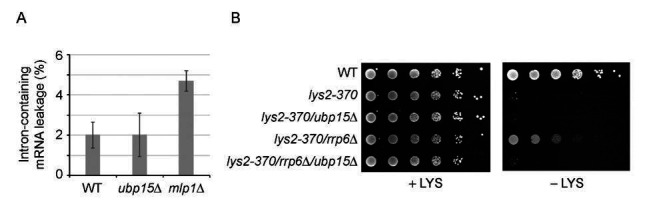
Deletion of UBP15 does not lead to increased levels of aberrant mRNAs in the cytoplasm.A) % of intron-containing mRNAs leaking into the cytoplasm, as measured using the “Leakage assay” described before (Legrain and Rosbash, 1989, Rain and Legrain, 1997) in WT, ubp15Δ and mlp1Δ cells. mpl1Δ is used as a positive control. B) The indicated mutants were grown overnight in YPD, serial-dilated (10-fold), and plated on YMB containing a complete set of amino acids (complete) and YNB lacking lysine (-LYS) Growth on – LYS indicates that the defective (but still functional) lys2-370 transcript is exported in the cytoplasm. rrp6Δ is used as a positive control.